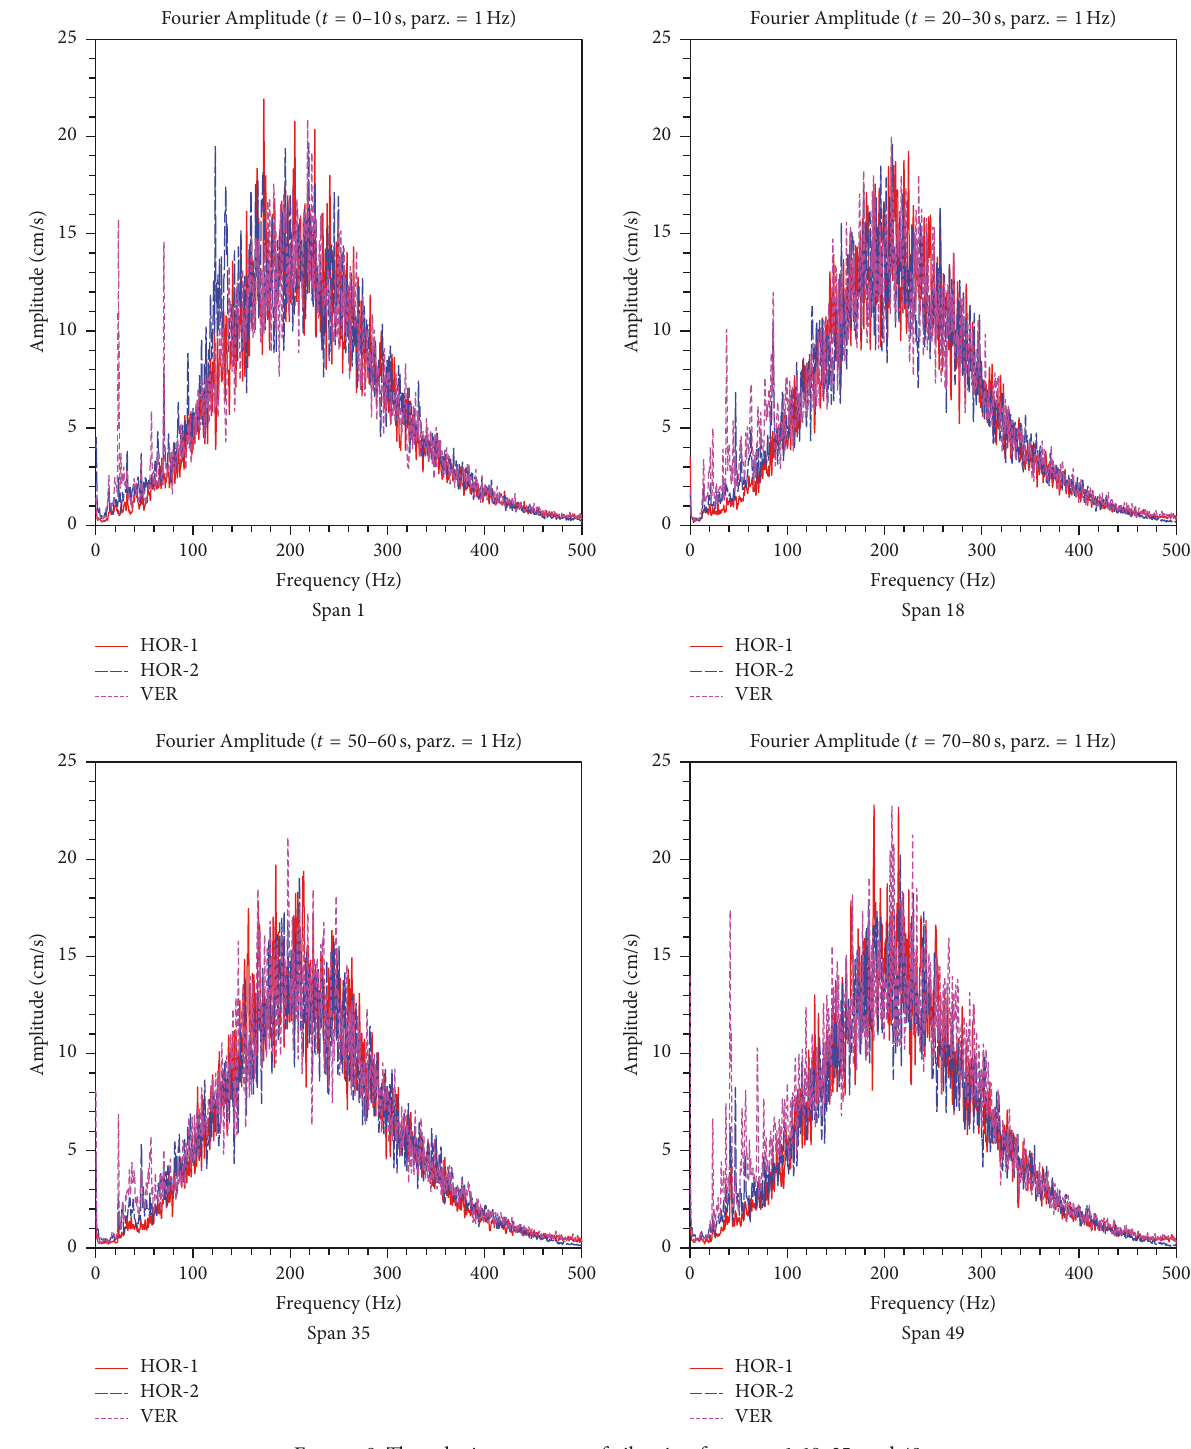
Figure 8: The velocity spectrum of vibration for spans 1, 18, 35, and